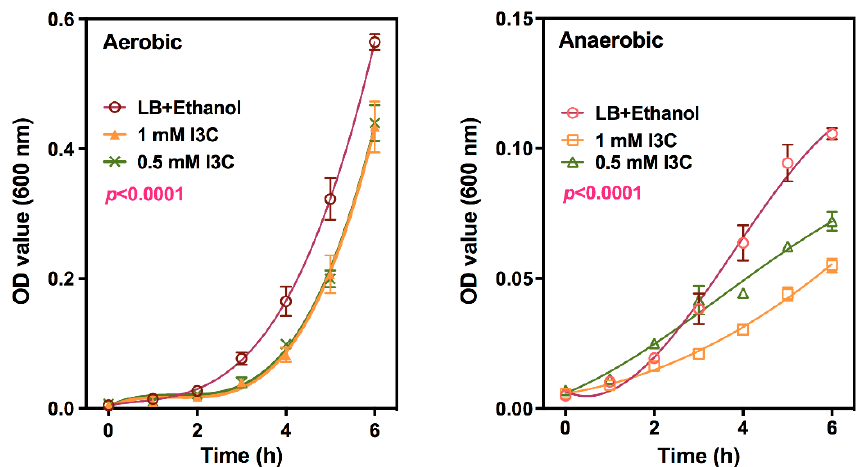
Figure 6. Effect of I3C on Cr growth in vitro. Cr (2×10 7 cfu/mL in LB medium) were grown in the presence of carrier (ethanol), 0.5 or 1.0 mM I3C at 37°C with shaking under aerobic or anaerobic conditions. OD 600 nm values were determined every hour after incubation by using microtiter plate reader. Data expressed as mean OD value ± SD ( n = 8).